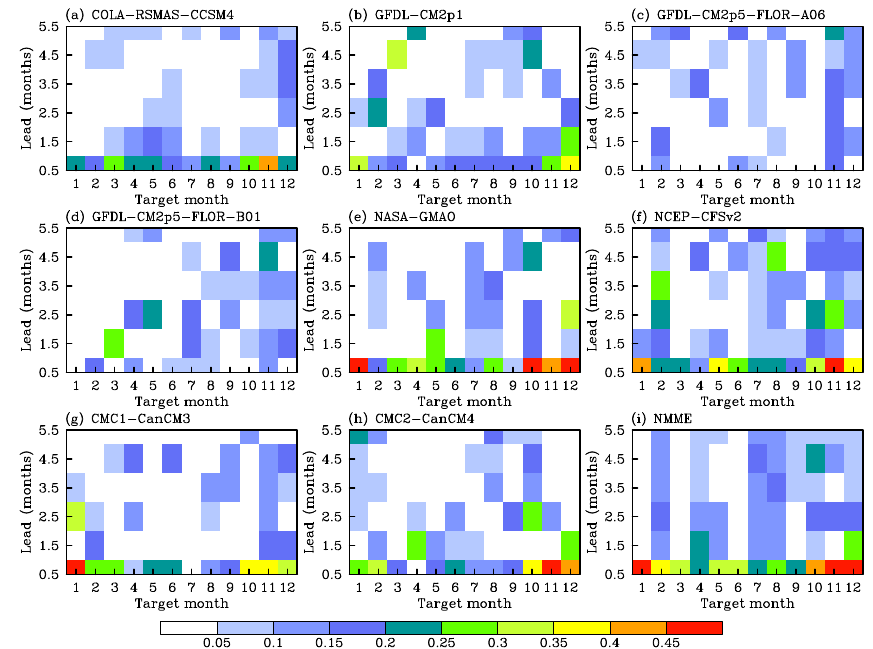
Figure 2. The same as Fig. 1 but for monthly mean